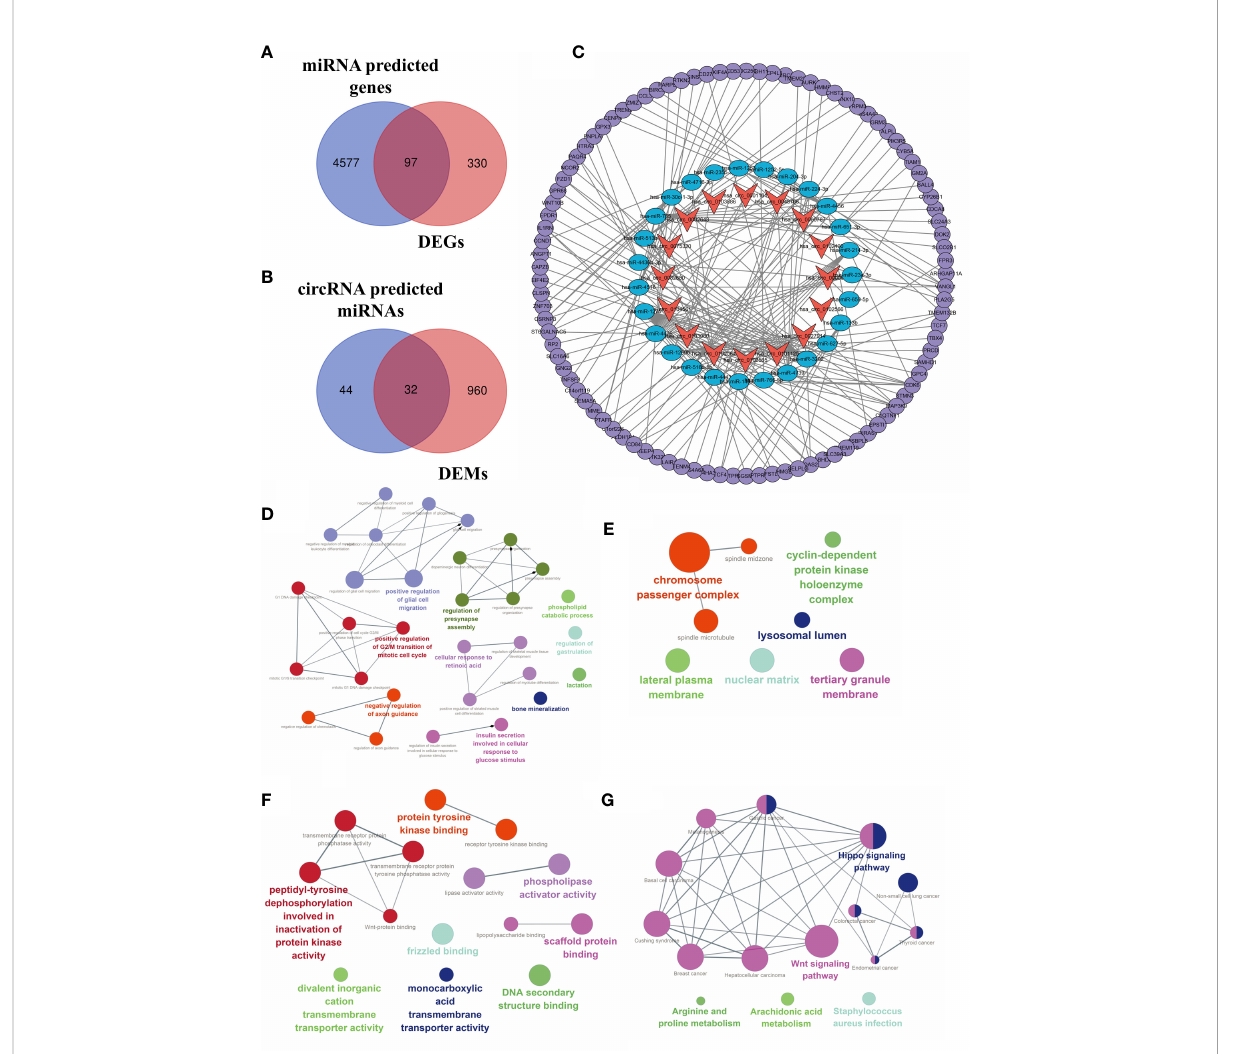
FIGURE 7 Construction of the circRNA – miRNA – mRNA regulatory network. (A) Venn diagram of the intersection of DEMs and predicted target genes. (B) The intersection of DECs and predicted target miRNAs. (C) The circRNA – miRNA – mRNA regulatory network. Orange arrows, DECs; blue ellipses, DETMs; purple circles, DETGs. Function annotation and KEGG analysis of hub DECs. (D) BP aspects; (E) CC aspects; (F) MF aspects; and (G) KEGG